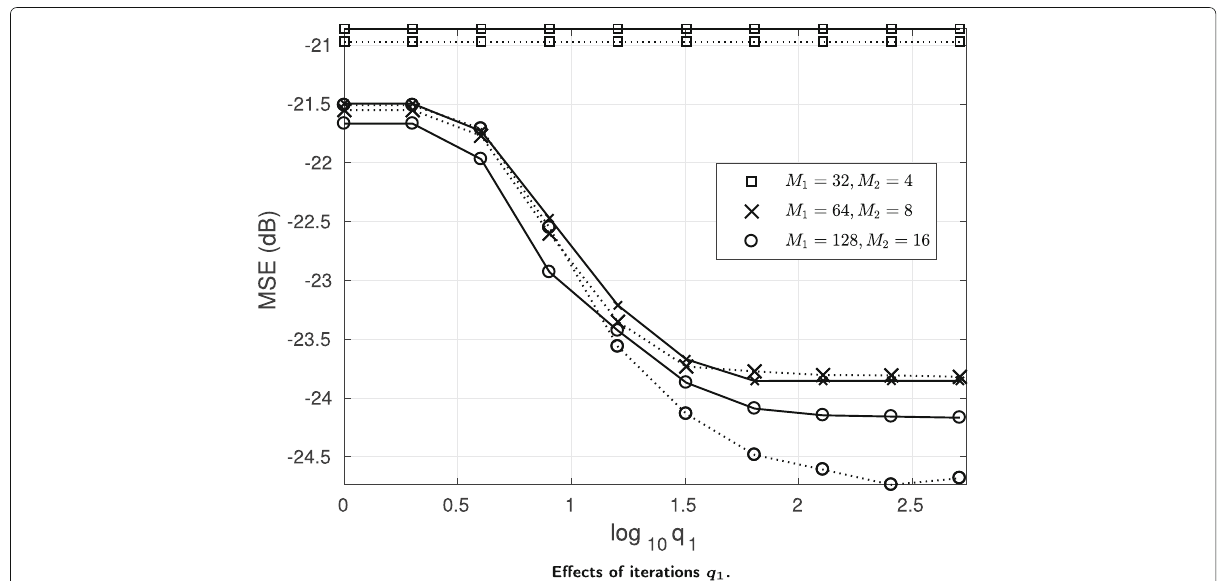
Fig. 3 Effects of iterations q 1 . MSE vs the maximum number of iterations q 1 for ULA with N r = 32, N t = 4 using AGDAR (solid lines) and RCS (dotted lines). UMi LOS model